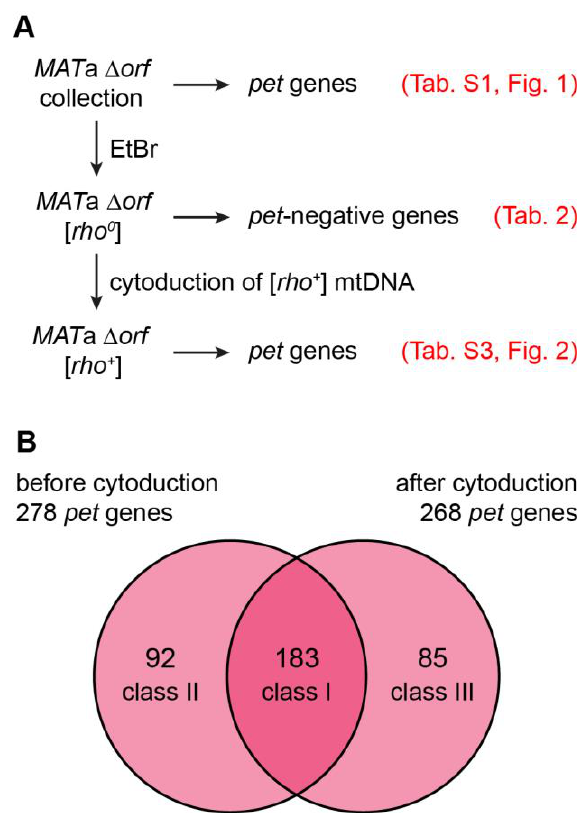
FIGURE 2: Contribution of mtDNA maintenance to the variabil- ity of pet phenotypes. (A) Flow chart depicting the experimental outline. In brief, the whole deletion collection was treated with EtBr to induce loss of mtDNA. Functional [ rho + ] mtDNA was re- introduced into each strain by cytoduction. The resulting [ rho + ] deletion collection was tested for growth on rich media contain- ing glycerol as nonfermentable carbon source. See text for de- tails. (B) Venn diagram comparing the sets of deletion mutants that showed a pet phenotype before and after EtBr-treatment and cytoduction. The mutants were grouped into three classes: Mutants that exhibited a pet phenotype before and after cyto- duction were classified as class I mutants, those that were res- cued by cytoduction were grouped into class II, and mutants that were unable to grow on media with glycerol as the carbon source only after cytoduction are referred to as class III mutants. Three of the 278 pet mutants from the original deletion collec- tion exhibited a petite -negative phenotype and were omitted from the